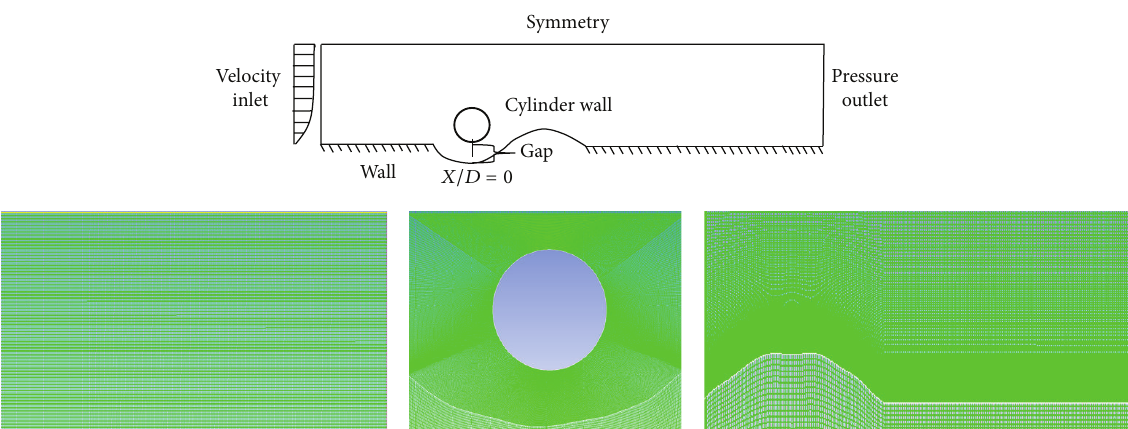
Figure 1: Geometrical model of computational domain and boundary conditions.